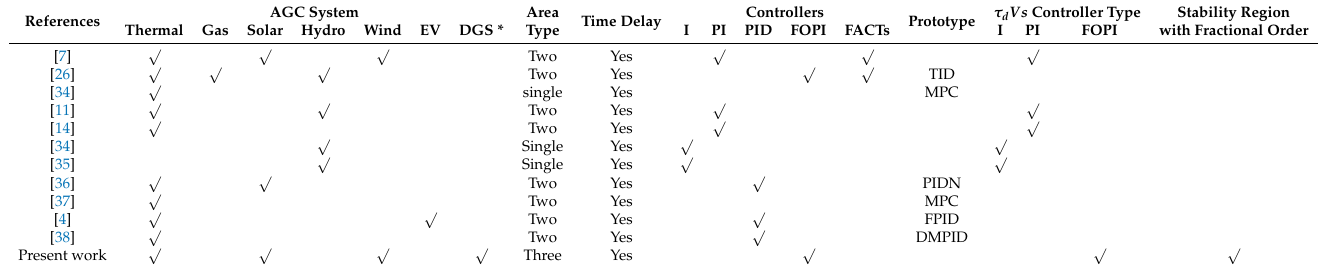
Table 1. The following is a taxonomy of the publications regarding the time-delay-based AGC system.